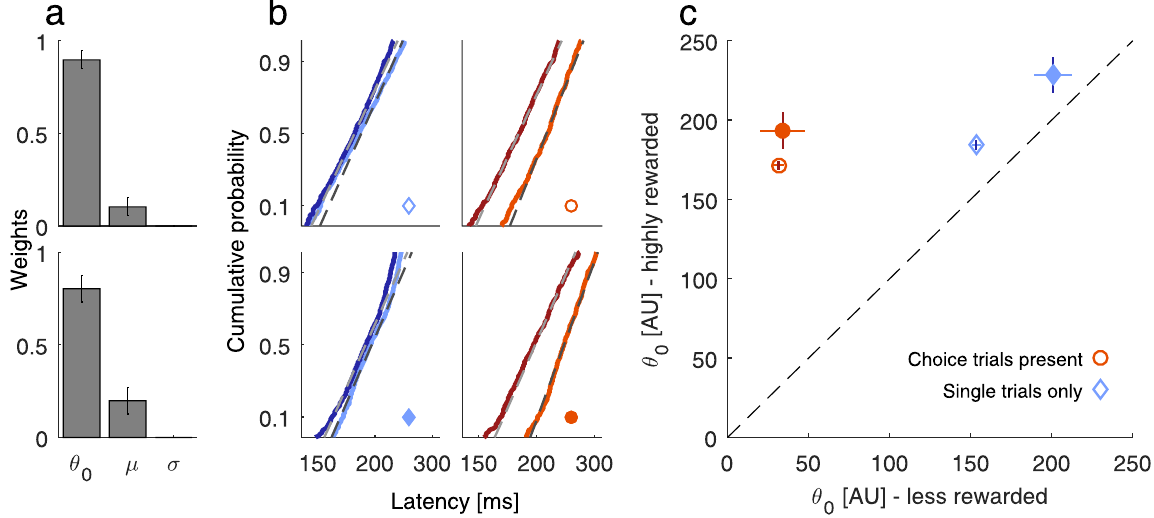
Figure 5. Results from the LATER model. ( a ) Information weights for the different model fits when each of the three parameters was allowed to differ across conditions. Values represent the mean weight with 95% confidence intervals across 100 Bootstrap samples. Each row (consistent with b ) represents a different participant. For both participants, the θ parameter, baseline level, was best in describing differences across conditions. ( b ) Reciprobit 0 plots of single-trial latency distributions to the highly (dark colors) and the less rewarded target (brighter colors) when choice-trials were present (right column; orange/red colors) or absent (left column; blue colors). Each row represents a different participant. Dashed lines are model fits for the high (bright gray) and low reward (dark θ parameters in ( c ). ( c ) Scatterplot of baseline levels, θ gray). Dots indicate which marker is used to plot the , for 0 0 the different conditions obtained by the model fit. Values represent the mean with 95% confidence intervals across 100 Bootstrap samples. Participants can be told apart by open or filled symbols (same as in b ). With choice-trials present (orange circles), baseline levels for less rewarded single-trial targets were strongly